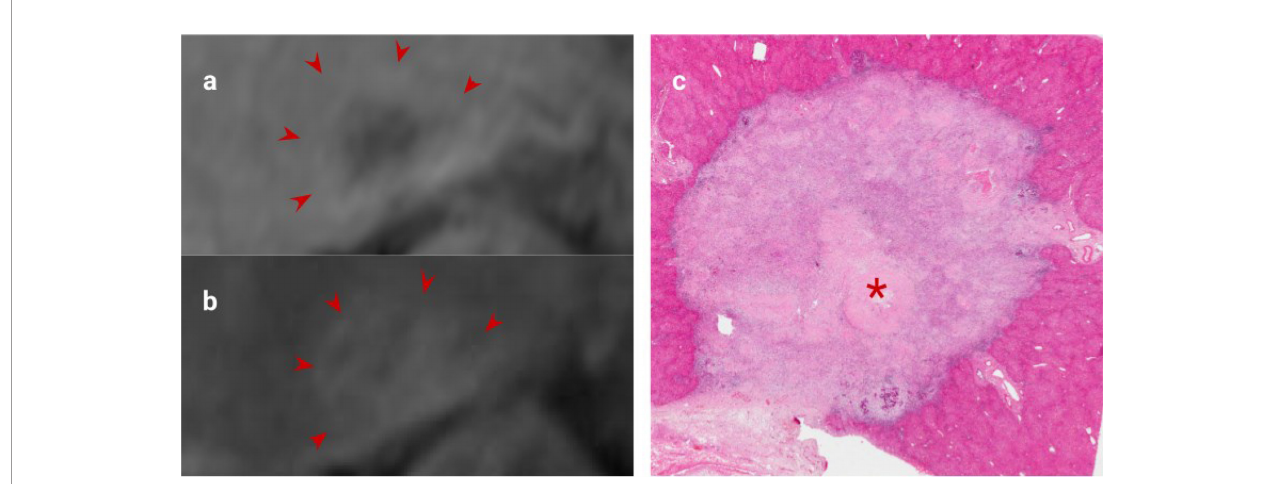
FIGURE 4 | CRLM imaging features following excellent response to Chemotherapy. (A) . Portal venous phase gadolinium-enhanced T1 fat saturated MRI showing decreased enhancement relative to liver (arrows), (B) . Delayed phase MRI showing increased enhancement relative to liver (arrows), (C) . H&E staining of this CRLM